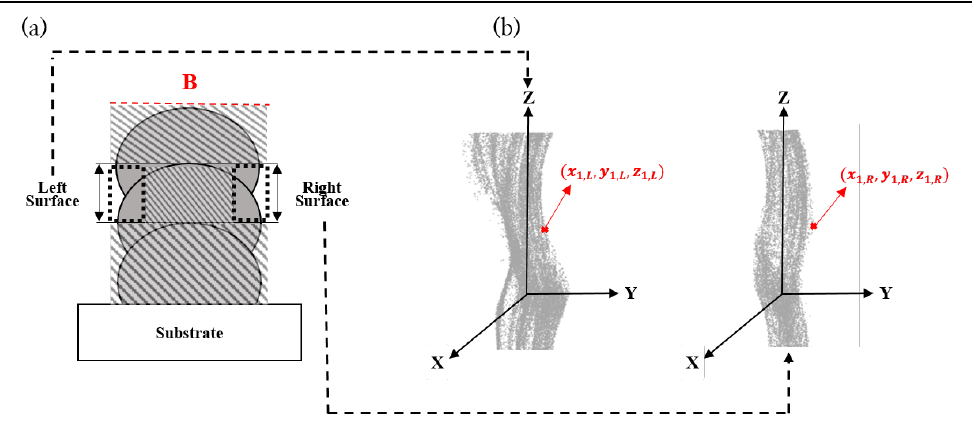
Figure 4. ( a ) Schematic diagram of cross-section of WAAM product. ( b ) Reconstruction of surface profile of both sides of a WAAM product between second and third layers by CMM.